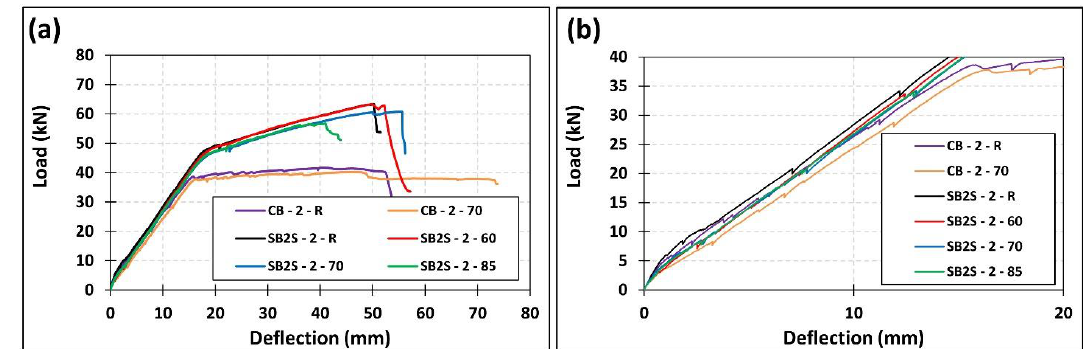
Figure 10. Effect of temperature on the experimental load–deflection curves of series 2 of specimens: ( a ) Total view; ( b ) Zoom in view.